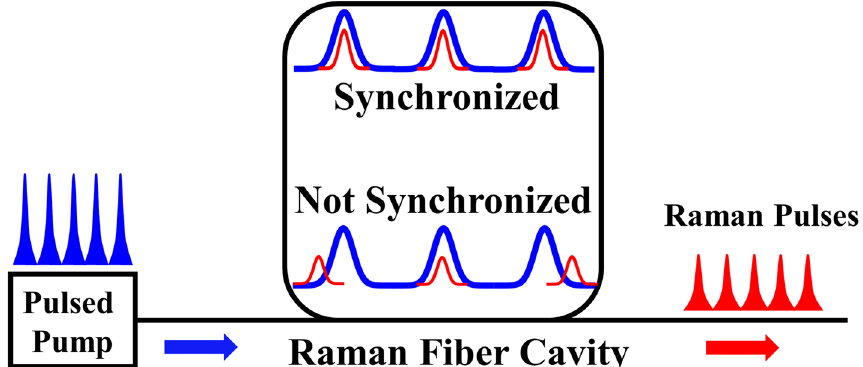
Fig. 8 Principle of synchronously-pumped Raman fiber laser. When the pump is pulsed, a critical matching condition needs to be met in order to achieve resonance enhancement, that is the repetition rate of the pulsed pump should match with the length of Raman fiber cavity